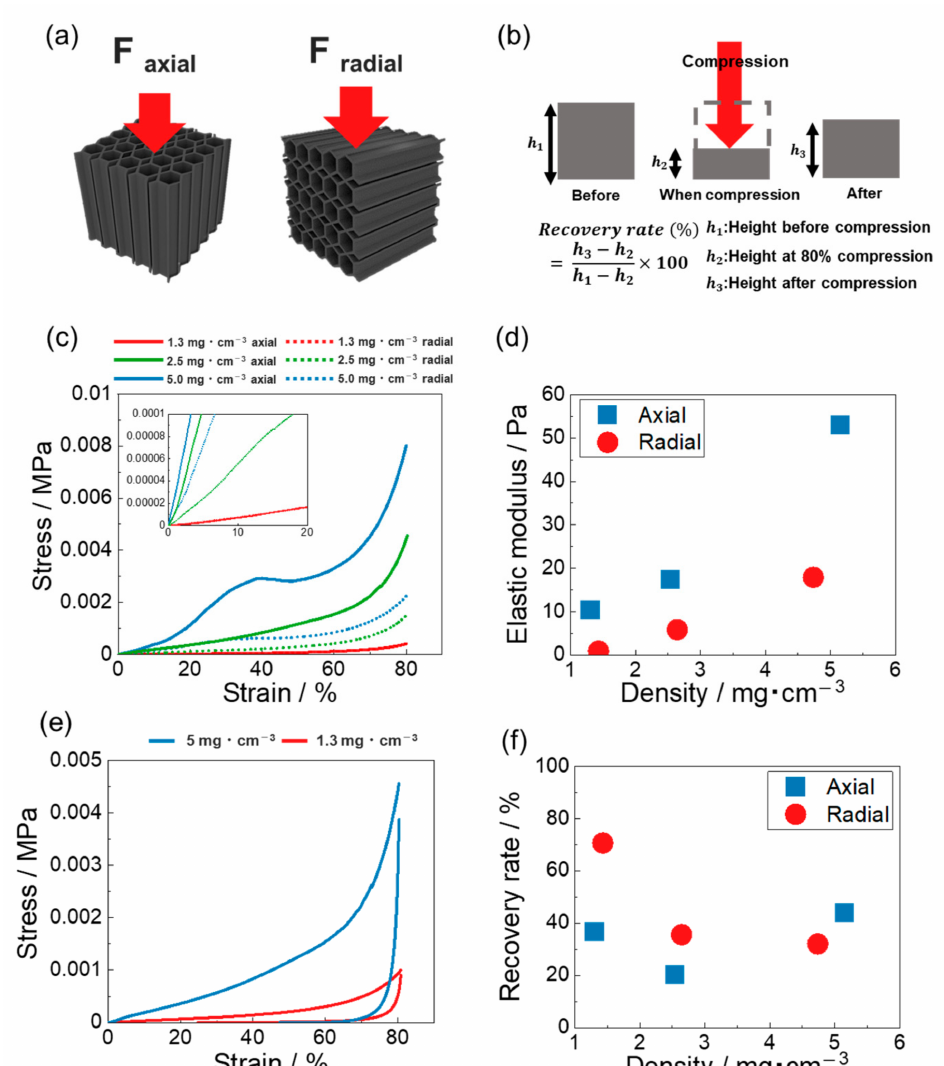
Figure 5. ( a ) Schematic of the compression directions. ( b ) Recovery rate calculation method. ( c ) Stress– strain curves of CNT/CMC2 (1.3_10), CNT/CMC2 (2.5_10), and CNT/CMC2 (5_10) in different compression directions. ( d ) Relationship between density and elastic modulus. ( e ) Stress–strain curves in radial direction for CNT/CMC2 (1.3_10) and CNT/CMC2 (5_10). ( f ) Relationship between density and recovery rate of the samples in different compression directions. (In ( d , f ), x-axis shows the actual measured